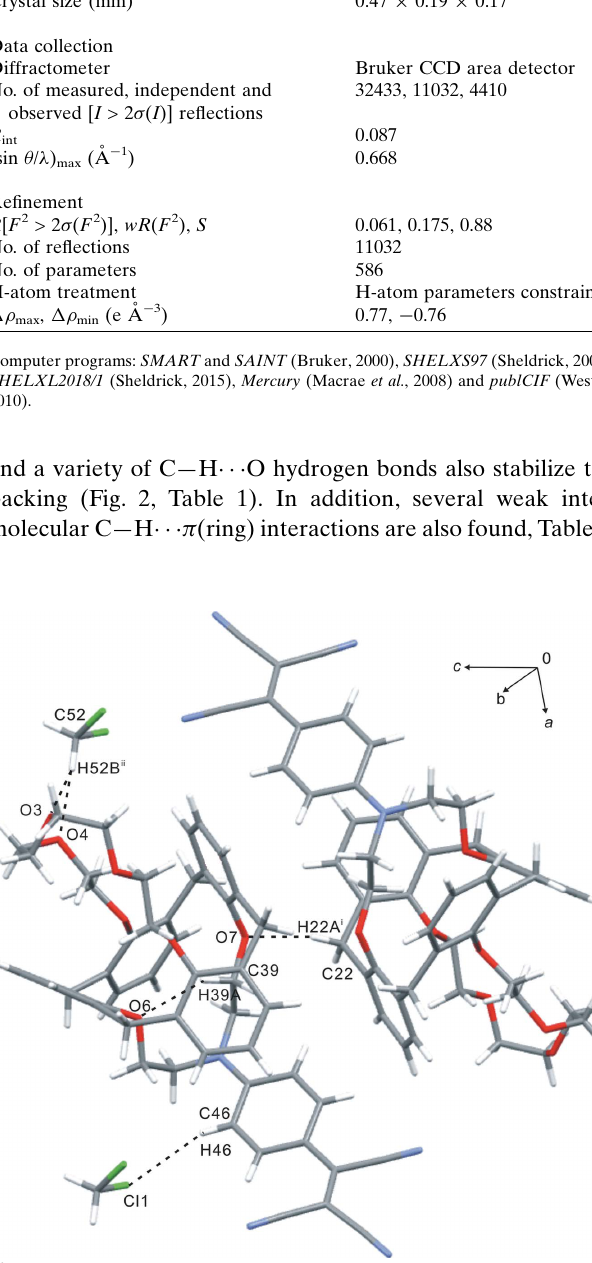
Figure 2 Crystal packing of the title compound with intramolecular and inter-